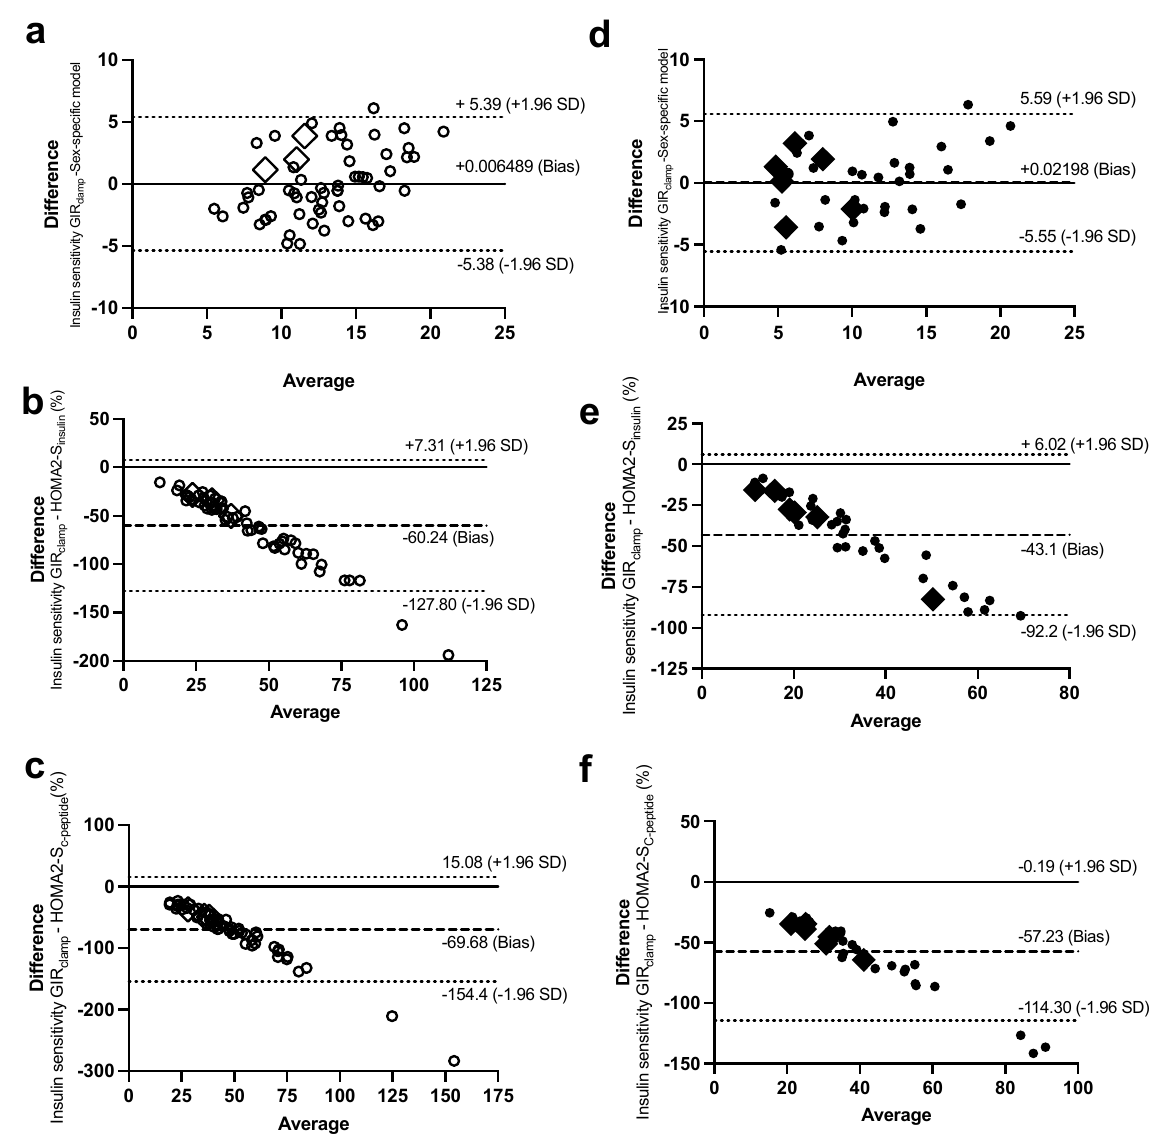
Figure 6. Bland–Altman plots with 95% confidence interval for limits of agreement of the IS measure during the Botnia-clamp with the sex-specific model for IS in women ( a ) and men ( d ), HOMA2-S insulin in women ( b ) and men ( e ), and HOMA2-S C-peptide in women ( c ) and men ( f ). Women are in open circles (N = 61, those with BMI > 40 kg/m 2 are in open diamonds) and men are in closed circles (N = 37, those with BMI > 40 kg/m 2 are in closed diamonds).